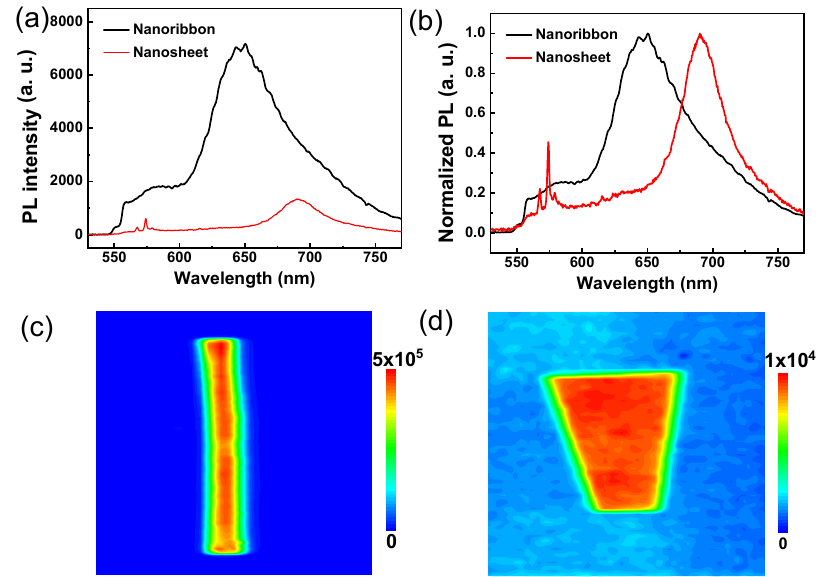
Figure 3. ( a ) PL spectra of pentacene nanoribbon (black) and nanosheet (red). ( b ) The normalized PL data of pentacene nanoribbon (black) and nanosheet (red). ( c , d ) PL-mapping images of pentacene nanoribbon crystal and nanosheet crystal, respectively.